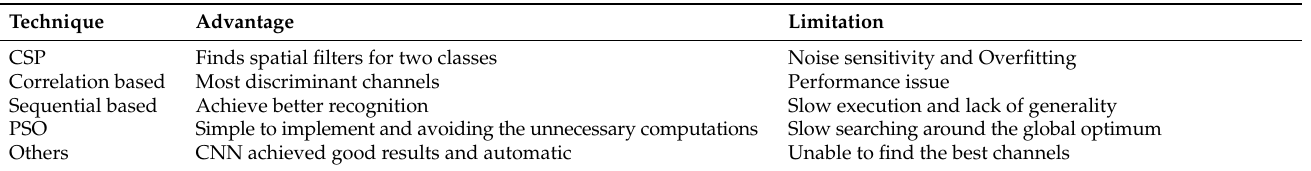
Table 7. Advantage and limitation of each